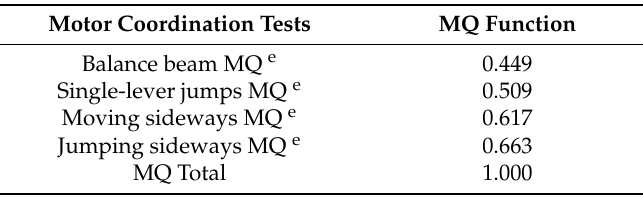
Table 5. The canonical structure